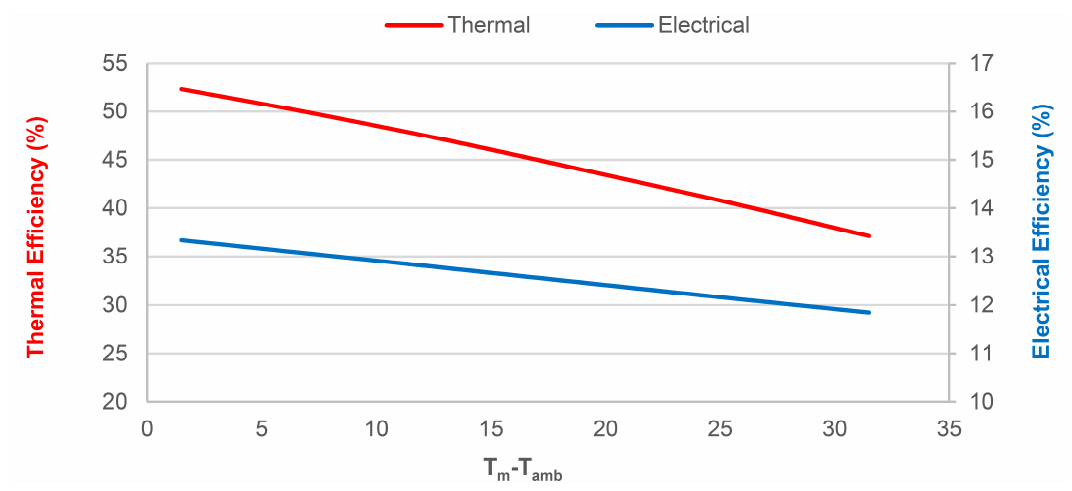
Figure 21. Thermal and electrical efficiency of the collector for different HTF temperatures .